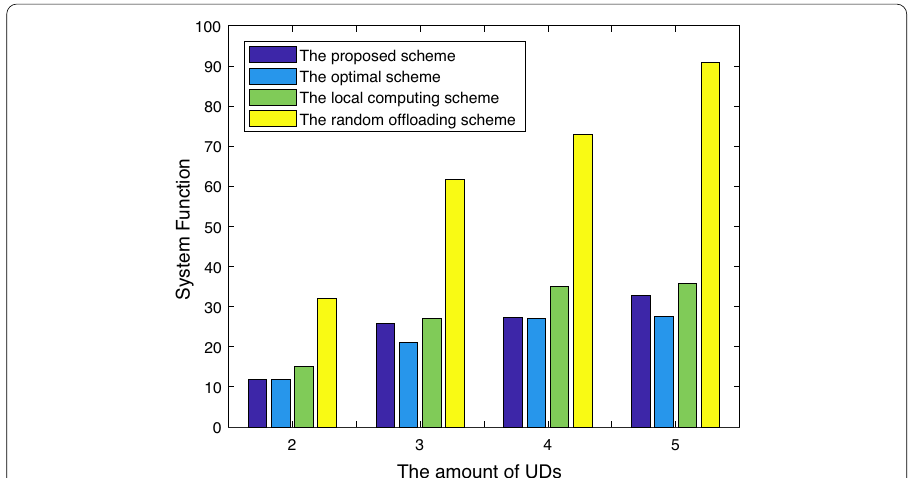
Fig. 8 The value of the system function of the proposed scheme versus the number of UDs (the simulation parameters of the network and the device are different in different scenarios)